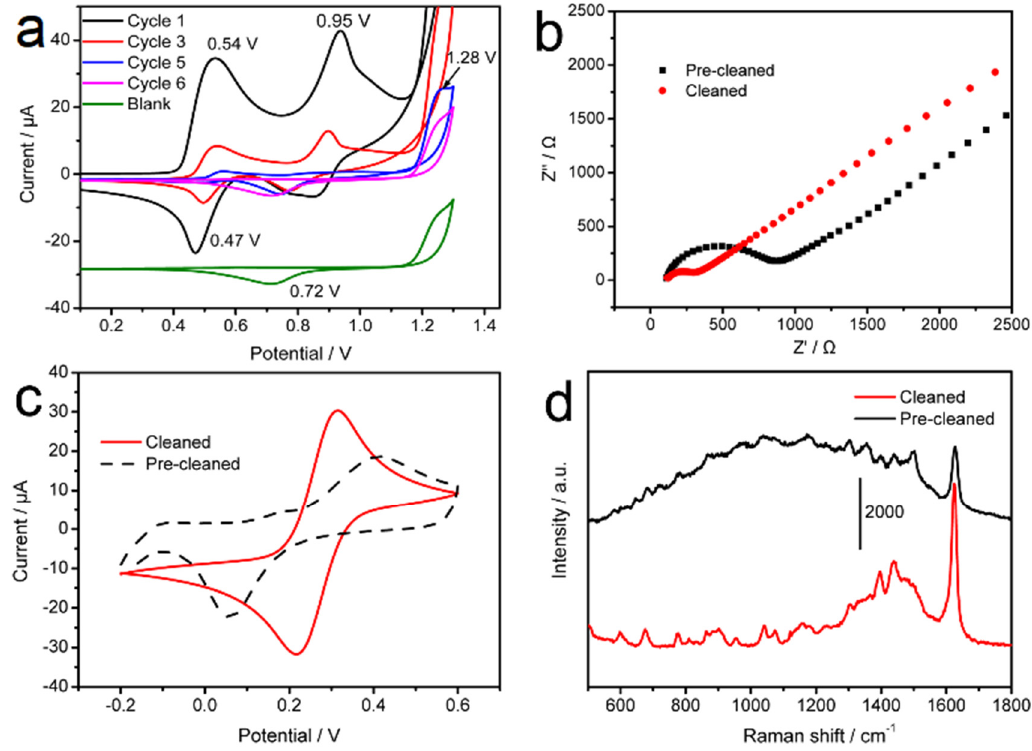
Figure 2. ( a ) CV curves of electrochemical cleaning of GCA electrodes, ( b ) EIS, ( c ) CV curves of [Fe(CN) 6 ] 3 − /4 − , ( d ) SERS spectra of MB on the GCA substrate before and after the cleaning process.